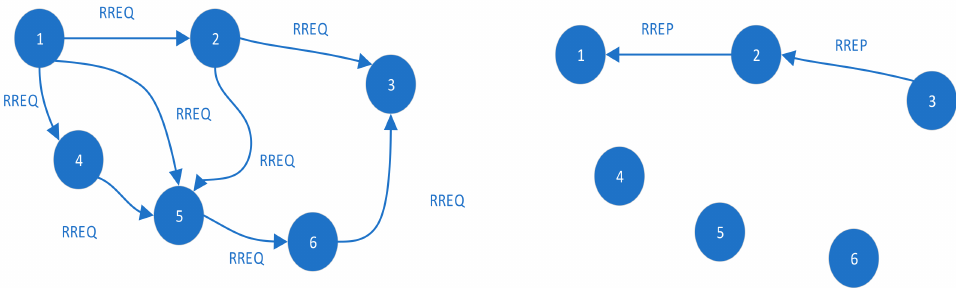
Figure 6. The AODV routing protocol route discovery process, where circles indicate nodes and numbers represent node indices.